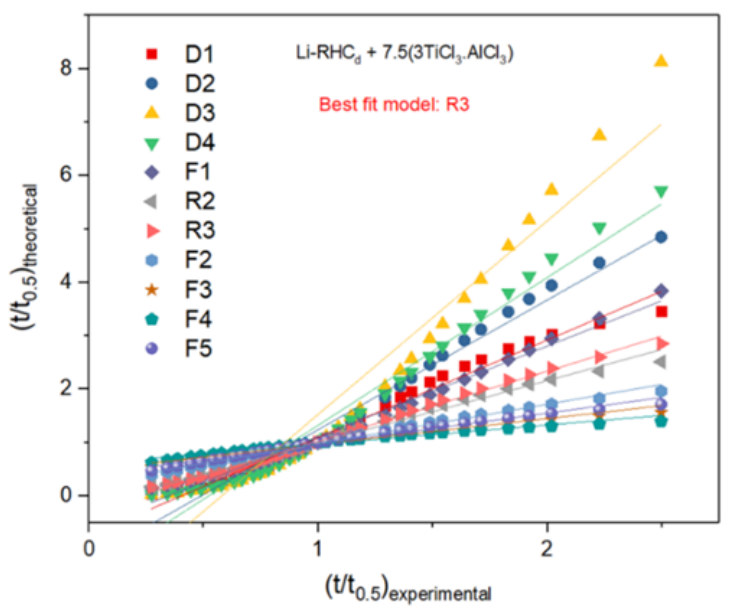
Figure 8. (t / t 0.5 ) experimental vs. (t / t 0.5 ) theoretical plots for Li-RHC d + 7.5(3TiCl 3 · AlCl 3 ) at the 2nd hydrogenation at 400 ◦ C and under 50 bar of H 2 . The method assumes that the most suitable reaction model provides a linear fitting with R 2 close to 1 and a slope of about 1. Table 2. Fitting parameters extracted from corresponding applied models (referred to Figure 8). Fraction from 0.10 to